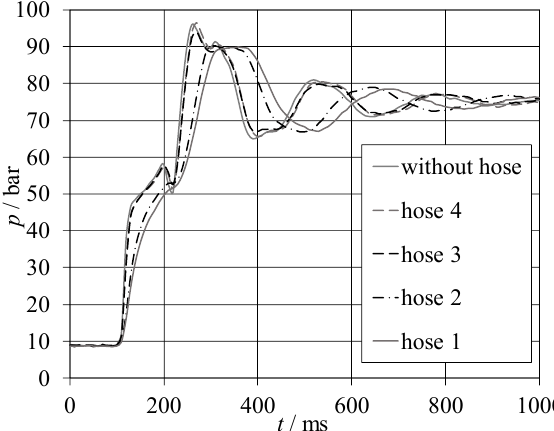
Fig. 3. Comparison of parallel capacitance influence